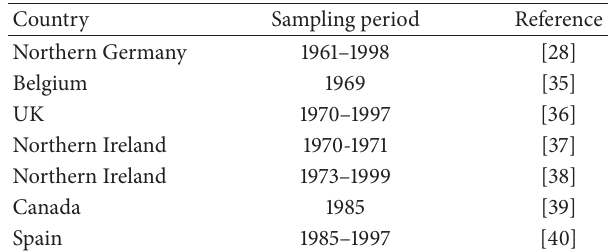
Table 1: Retrospective studies on earlier occurrence of PCV2 in pigs from some countries of the